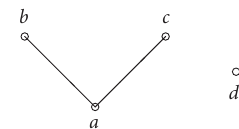
Figure 2: Figure of S for Example